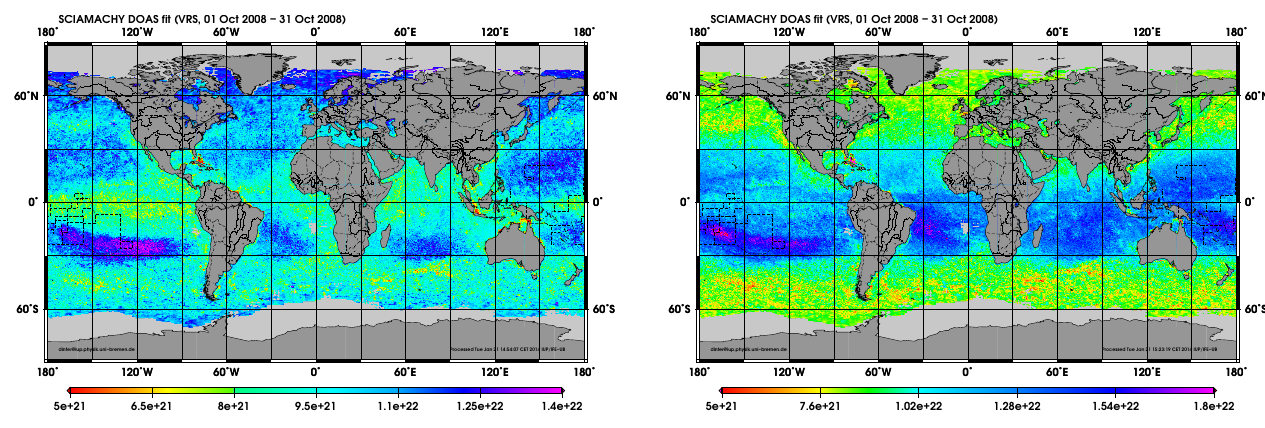
Figure 13. Global map of the depth integrated scalar irradiance E 0 at 390–444.5nm from DOAS VRS weighting function fits in unit of photonss − 1 m − 1 including the SZA correction from Fig. 10. Red shows low and blue–magenta high E 0